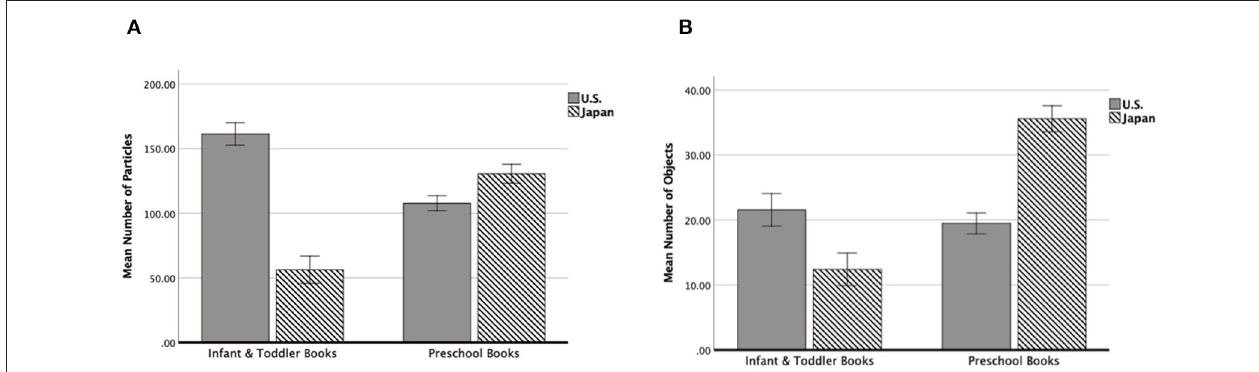
FIGURE 2 | The bar graph of the average number of particles counted by the ImageJ (A) and the average number of objects counted by the human coders (B) . The x-axis shows the books targeting different age groups (infant/toddler and preschool) and the y-axis shows the mean number counted by each coding method. The gray bars are for the U.S. picture books and the striped bars are for Japanese picture books. The error bars were set as + /– 1 SE.